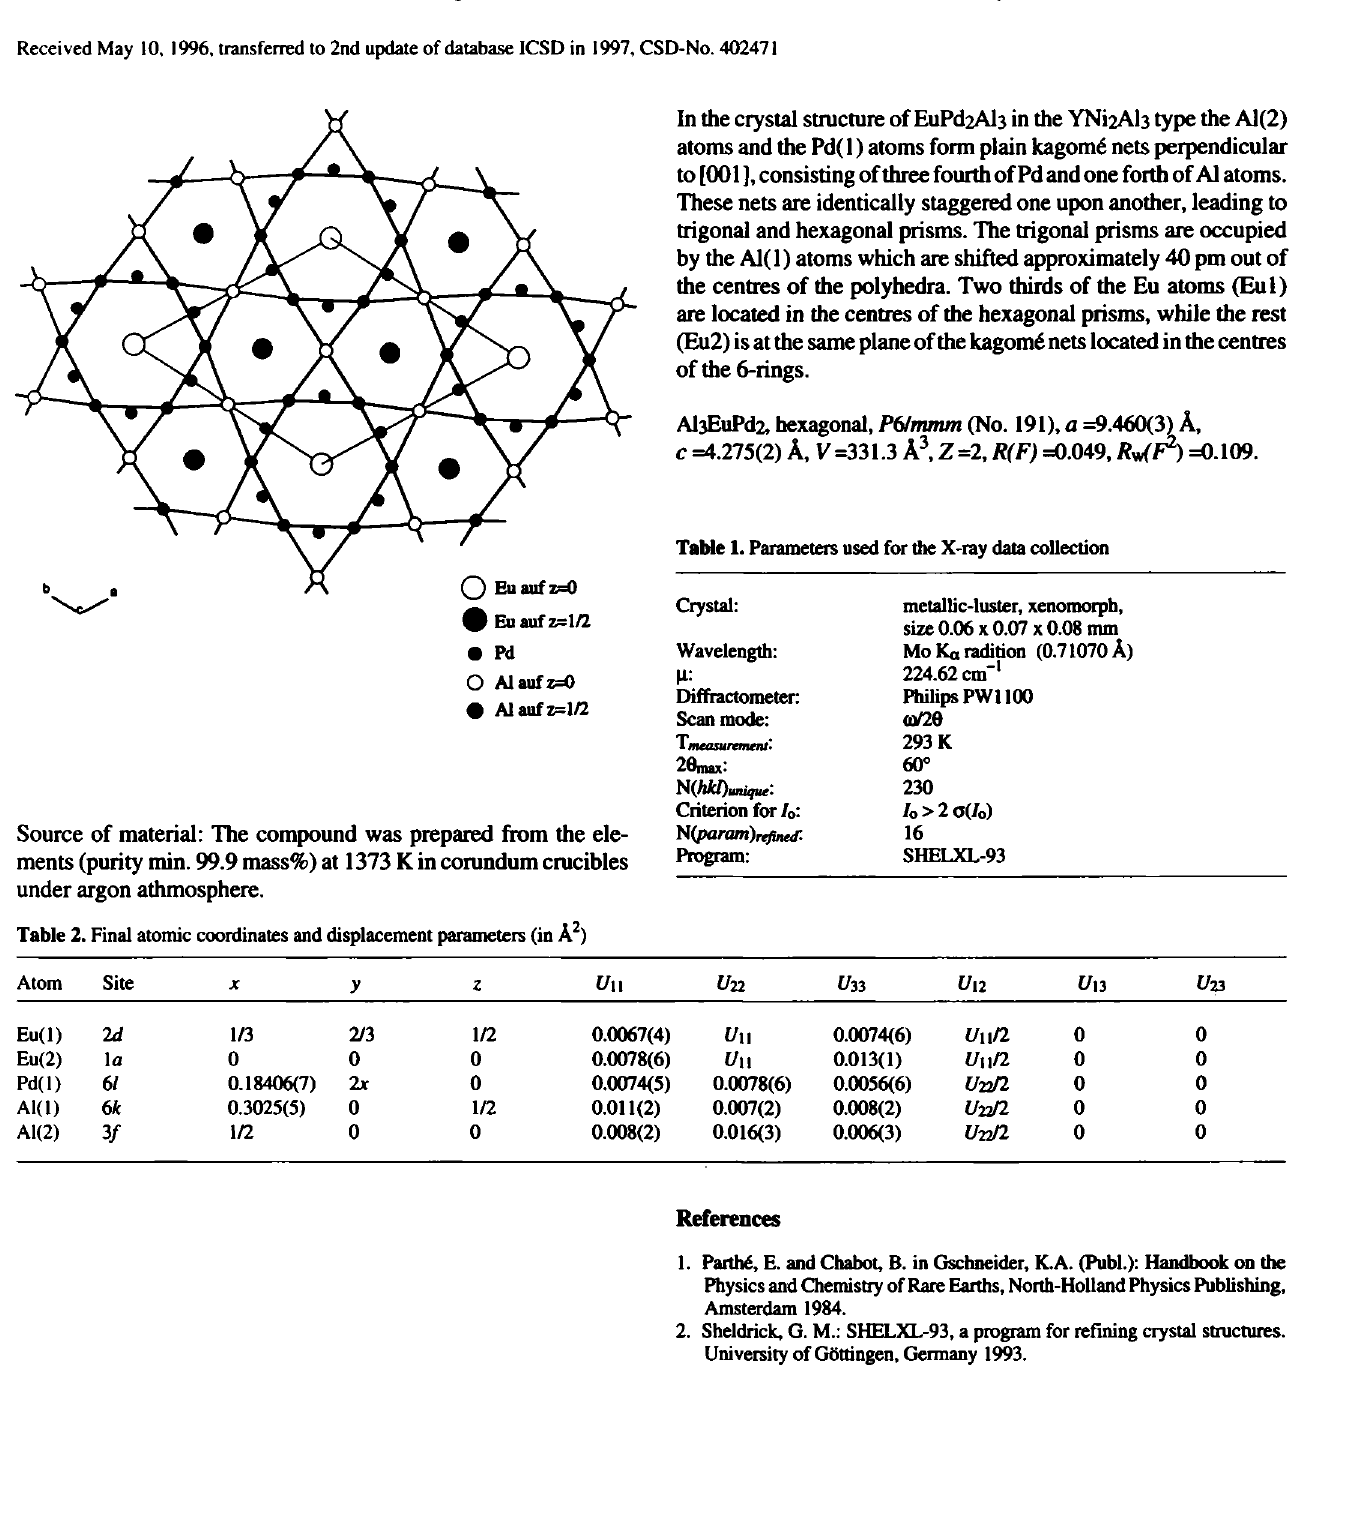
Table 2. Final atomic coordinates and displacement parameters (in Â 2 ) Atom